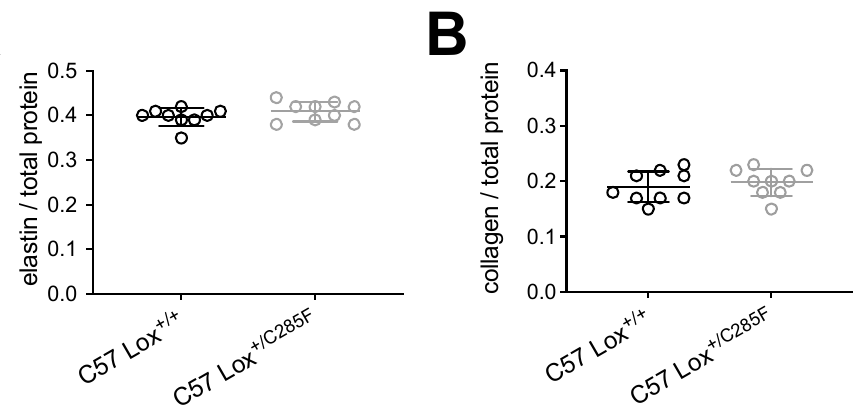
Figure 6. Elastin and collagen content in Lox +/C285F mice. ( A , B ), No differences were noted in the total quantity of elastin (( A ), t -test) and collagen (( B ), t -test) deposited in C57 Lox +/C285F vs. Lox +/+ aortas.